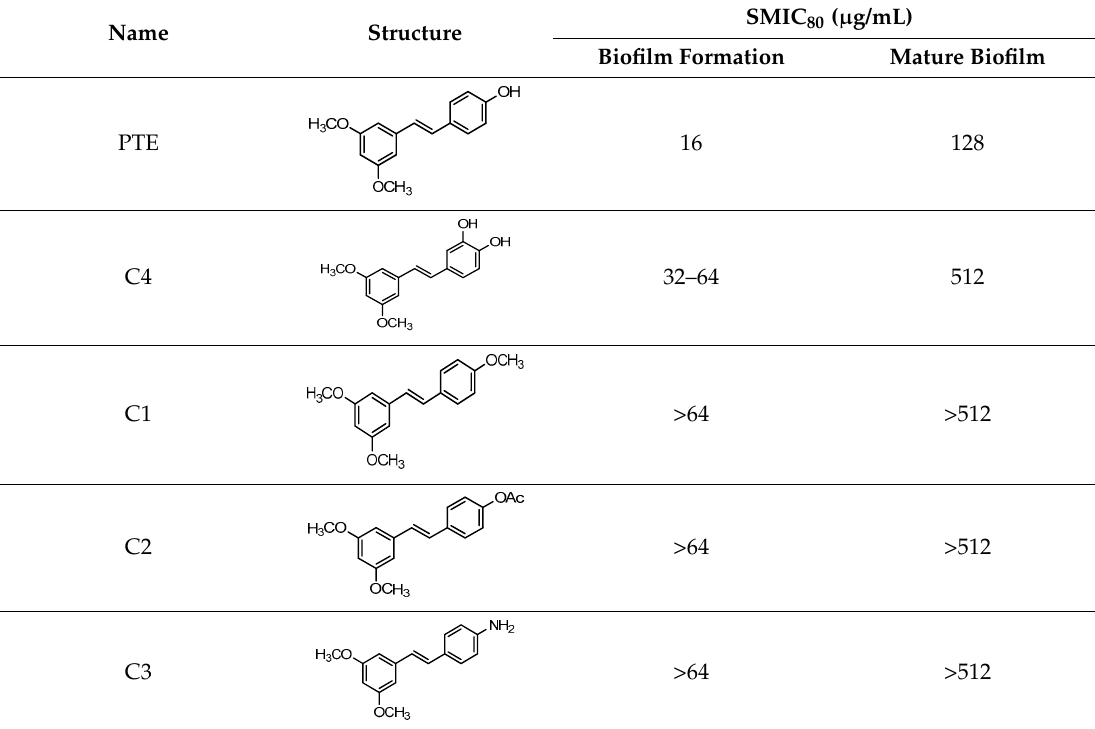
Table 1. Structure and SMIC 80 of PTE and its analogues.